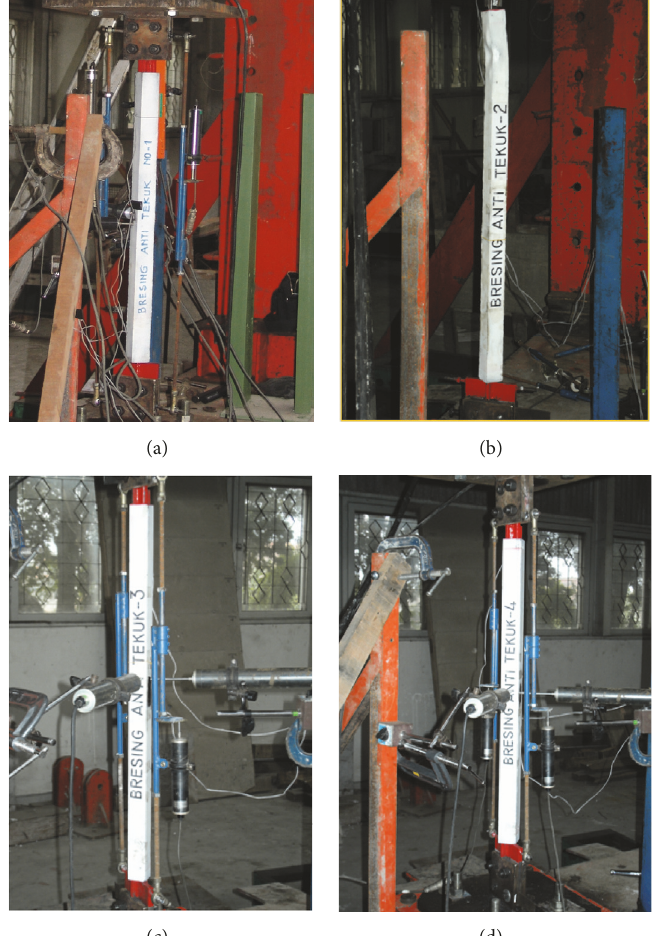
Figure 14: Deformed shapes at the completions of the tests (at strain of 2 percent): (a) SBRB-1; (b) SBRB-2; (c) SBRB-3; (d)